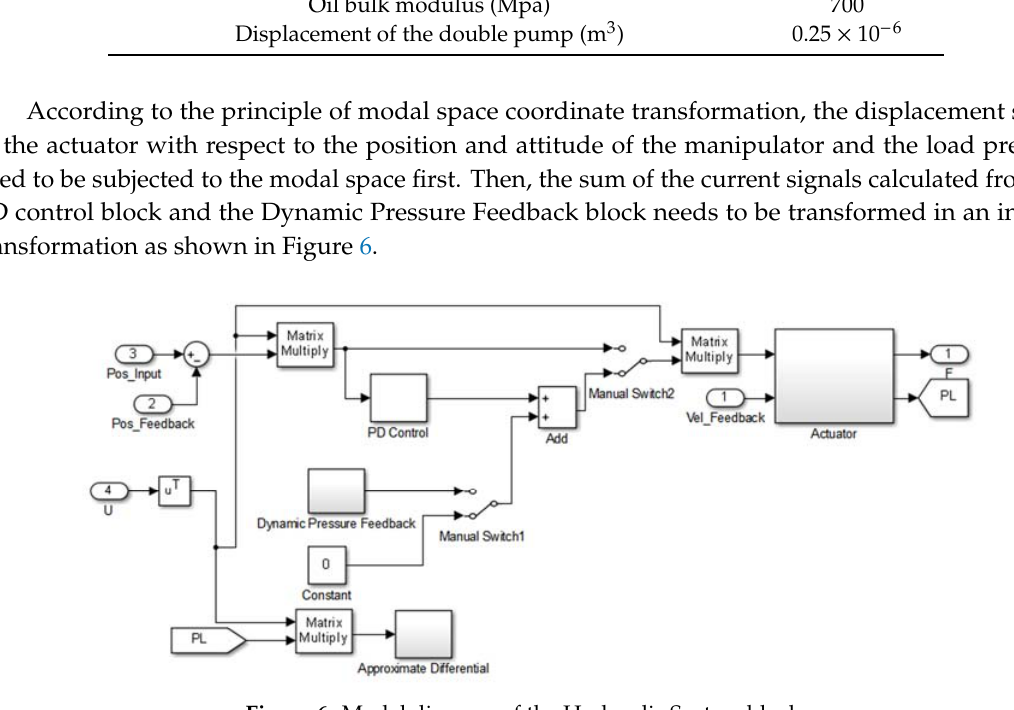
Figure 6. Model diagram of the Hydraulic System block.